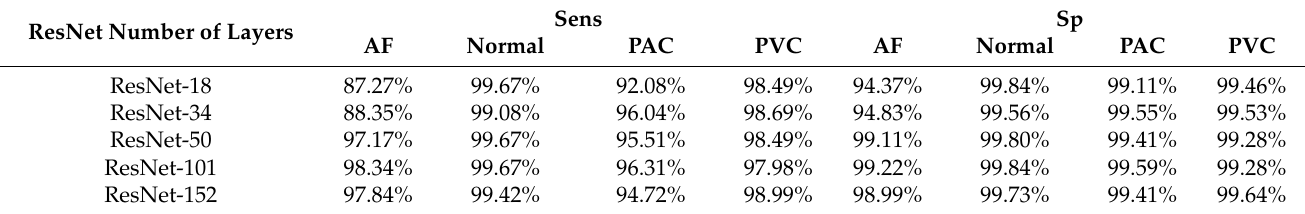
Table 6. Second stage Sens and Sp for the selection of the ResNet